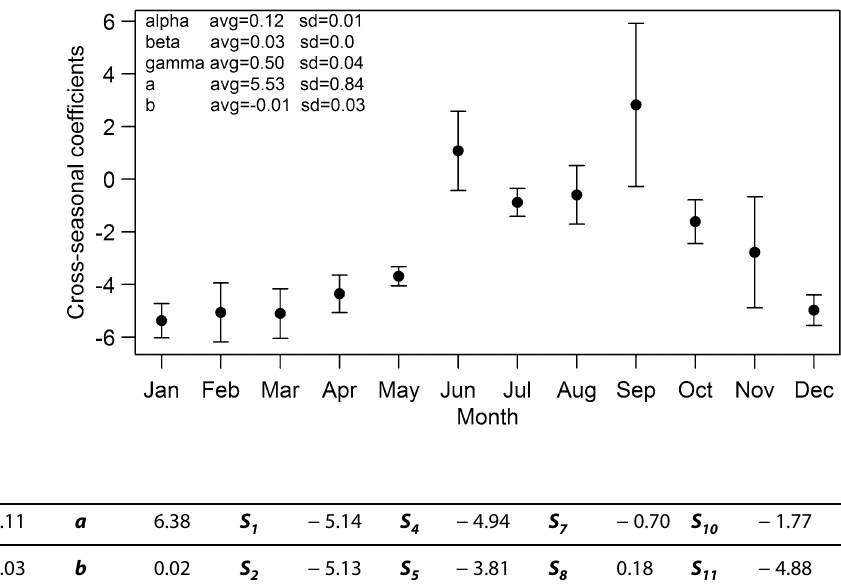
Smoothing coefficients are dimensionless, and the other parameters have units of m